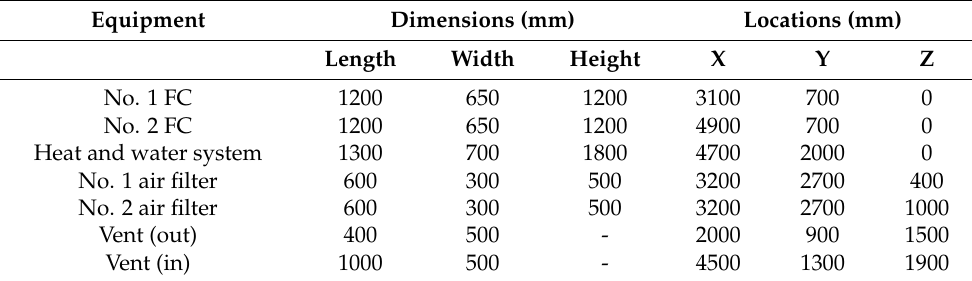
Table 4. Dimensions and locations of the equipment in the fuel cell